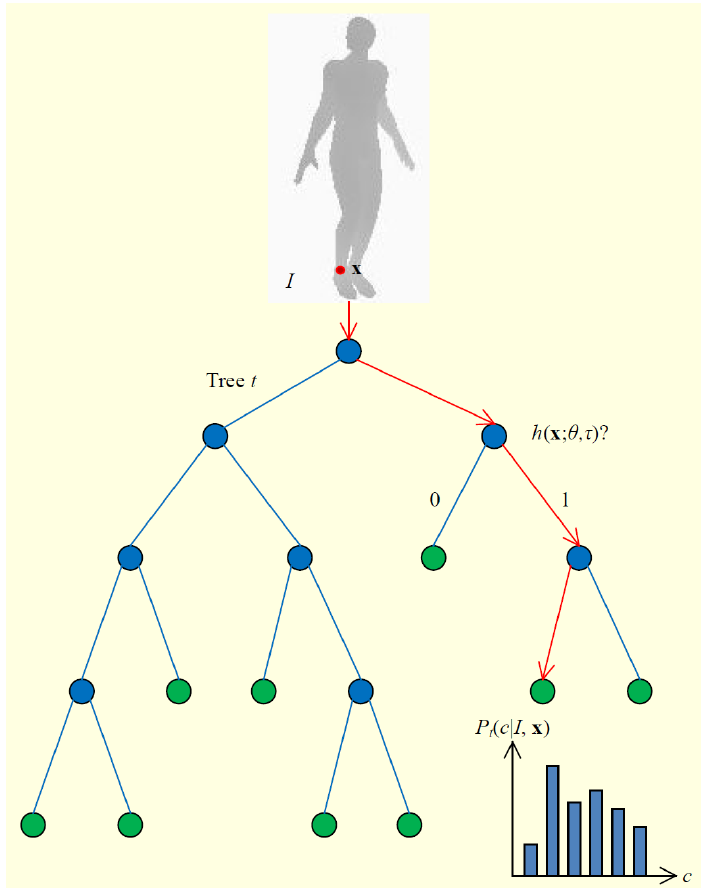
Figure 14. A tree that composes random forests [167]. The tree consists of split nodes (blue) and leaf nodes (green). The red arrows indicate the path that is taken for a particular